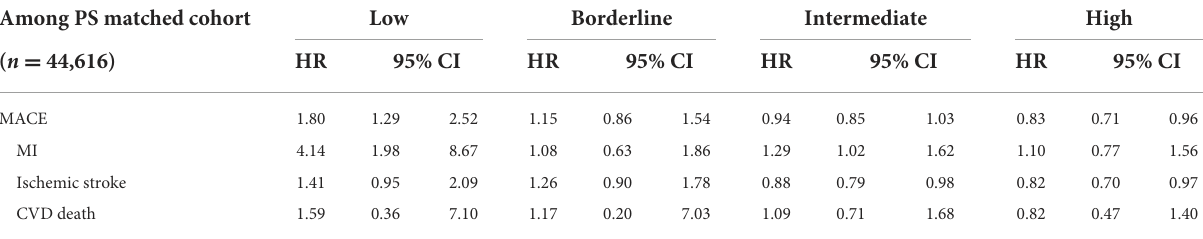
TABLE 3 Hazard ratio of MACE by 10-year ASCVD risk categories.